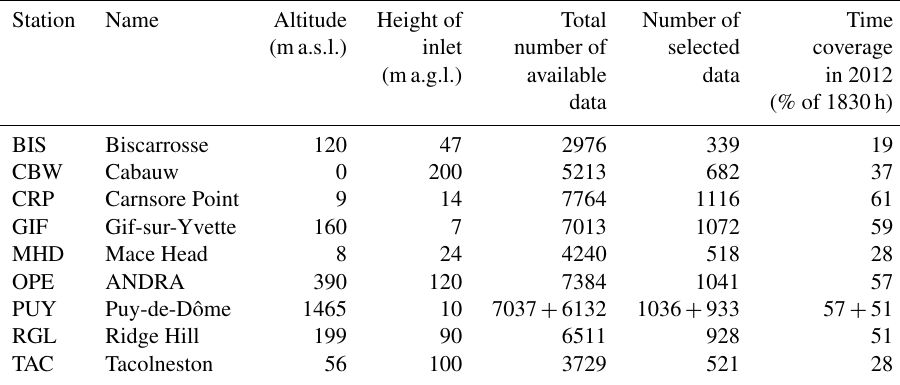
Table 1. Characteristics of the available stations at the time of the study (see map in Fig. 3). The altitude is above sea level; the height is above ground level. The total number of available data is the number of hourly means available for the whole year (i.e. maximum 8784). The number of selected data is the number of hourly means available from 14:00UTC (included) to 19:00UTC (not included) when the boundary layer height is higher than 500m in the model. The time coverage is computed over the afternoon hours (14:00–18:00UTC), i.e. 100% for 1830h. At PUY, two different instruments measure CH 4 . Station Name Altitude Height of Total Number